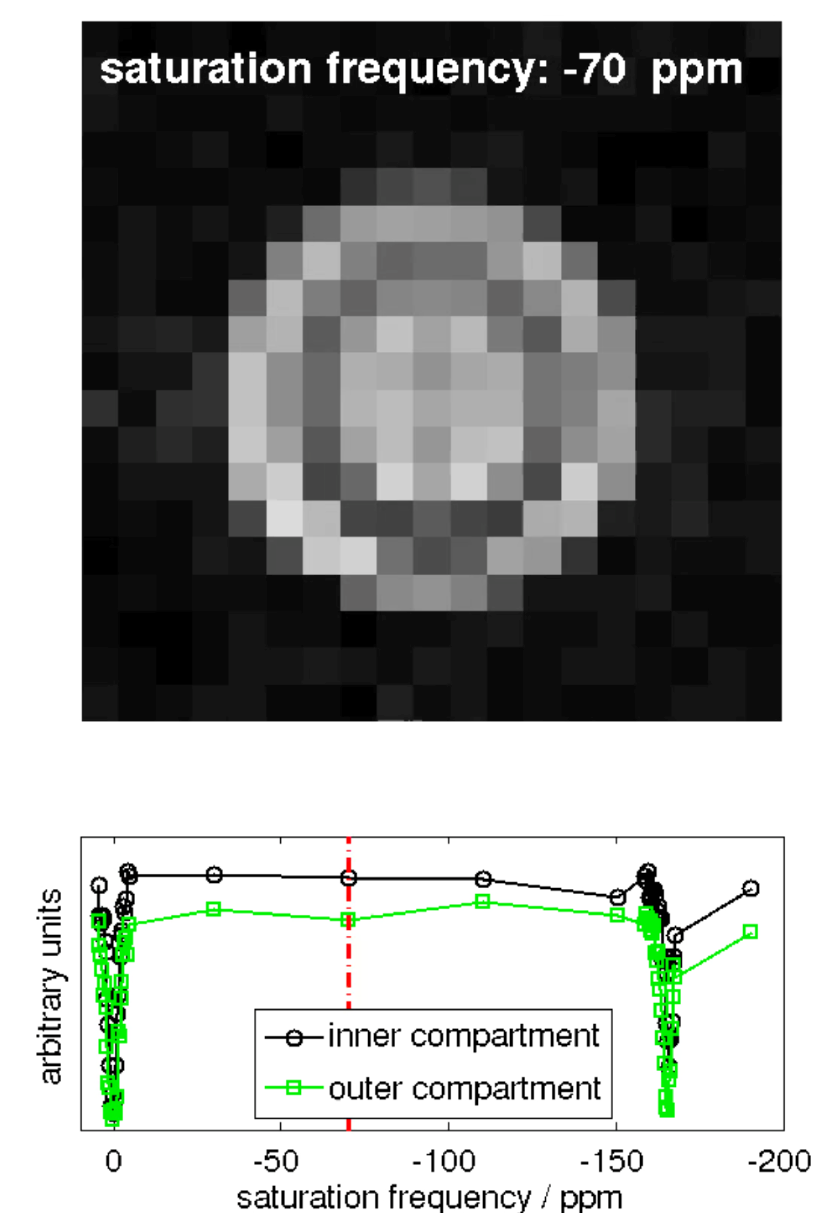
Figure A1. Snapshot of the animation of the 129 Xe MR image series obtained with a Hyper-CEST EPI pulse sequence. The video itself can be found in the online Supplementary